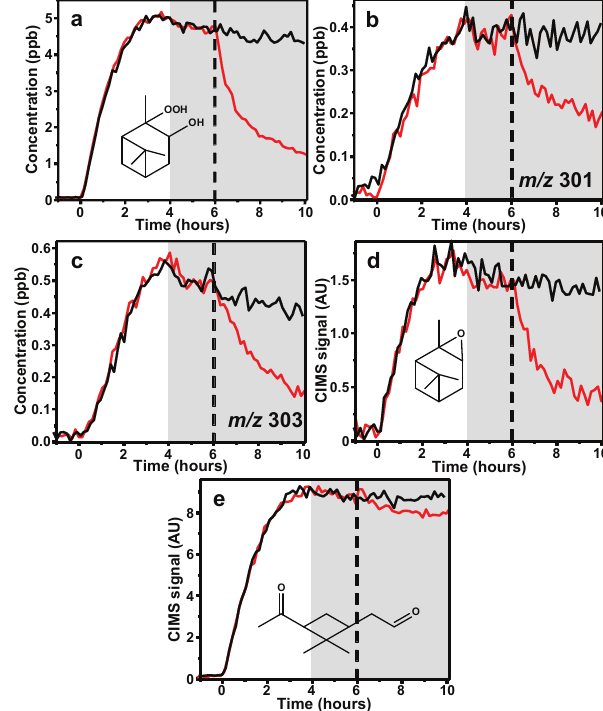
Fig. 8. CIMS traces of α -pinene OH oxidation under low-NO x con- ditions, photooxidation for four hours, lights off and contents in the dark for two hours followed by injection of ammonium sulfate seed (black) or ammonium sulfate and sulfuric acid seed (red). Shaded gray area is when the chamber was dark and the dashed line indi- cates when aerosol seed was